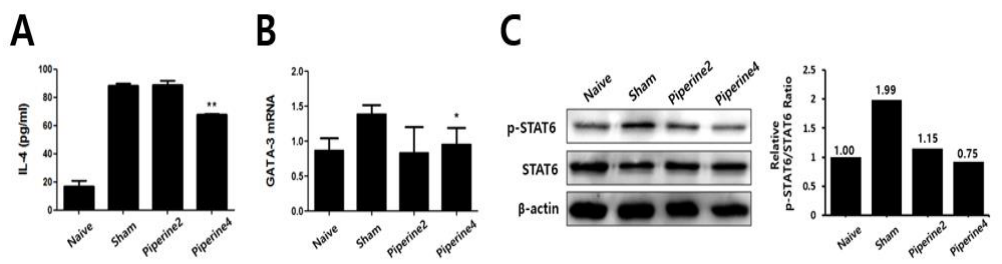
Figure 4. Effect of piperine on TMA-induced Th2-associated immune responses in dLNs. The dLNs were seeded to 1 × 10 6 cells/mL and cultured in the presence of Con A (2 μg/mL) for 48 h. ( A ) The secretion of IL-4 cytokine, ( B ) the mRNA levels of GATA3, and ( C ) STAT6 phosphorylation were measured by ELISA, RT-PCR, and Western Blot assay, respectively. The results are shown as the means ± SD ( n = 3). Asterisks (*) and (**) indicate significant differences between piperine-treated groups and sham groups of TMA-induced AD-like mice at p < 0.05 and p < 0.01, respectively.